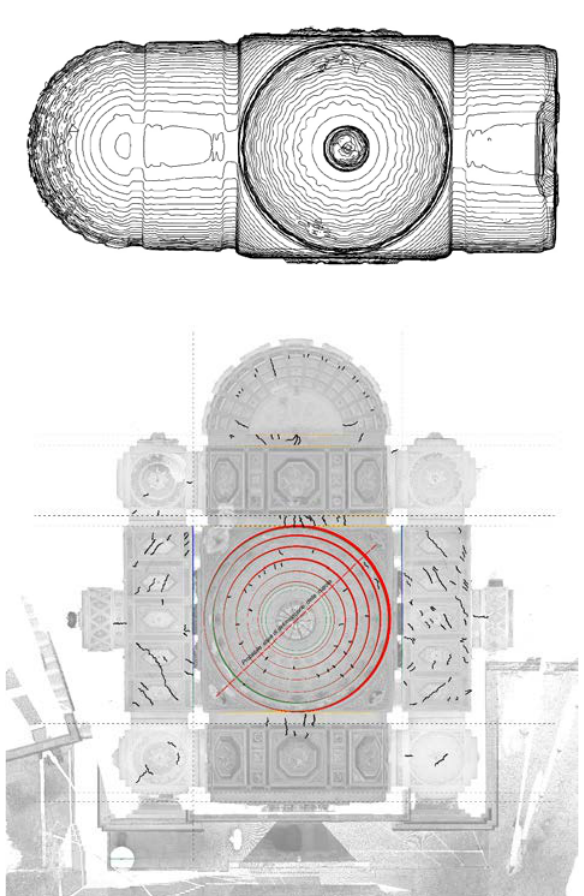
Figure 11. Geometrical analysis of the vaults and the dome: contour map of levels (top), hyposcopic plan (bottom) with cracking pattern and dome deformation representation.